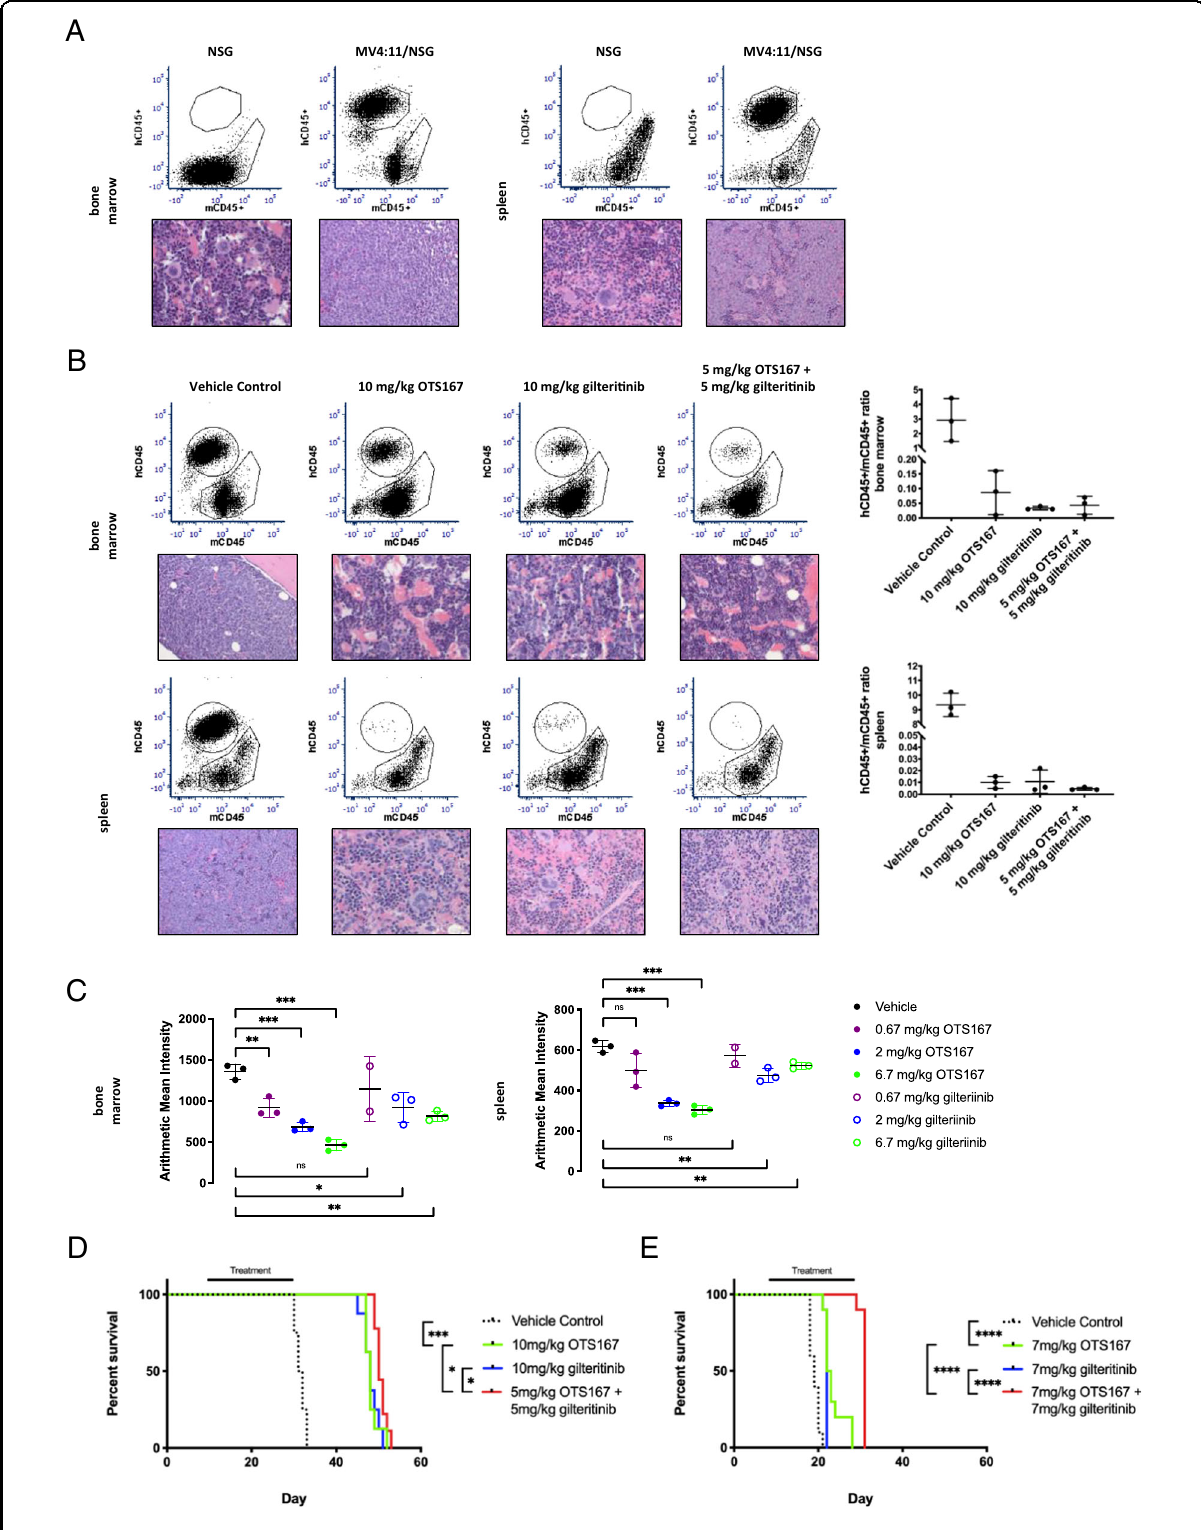
Fig. 6 (See legend on next